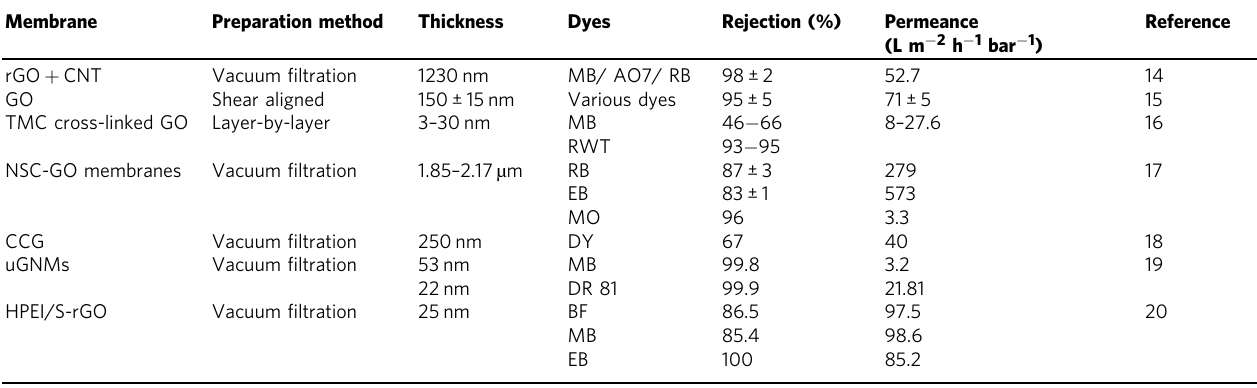
Table 2 Benchmarking of graphene-based membranes for organic dyes separation Membrane